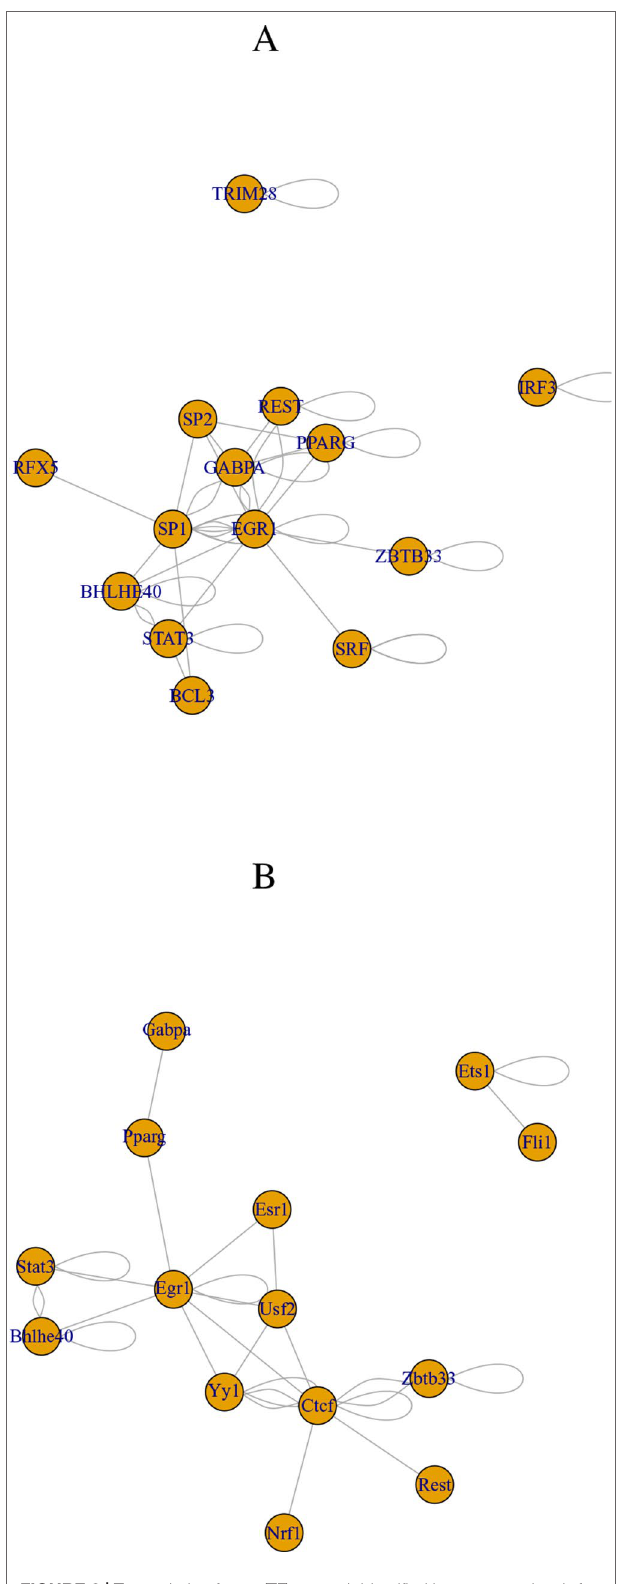
FIGURE 2 | Transcription factor (TF) network identified by regnetworkweb for TFs in Table 9 . (A) Human and (B)